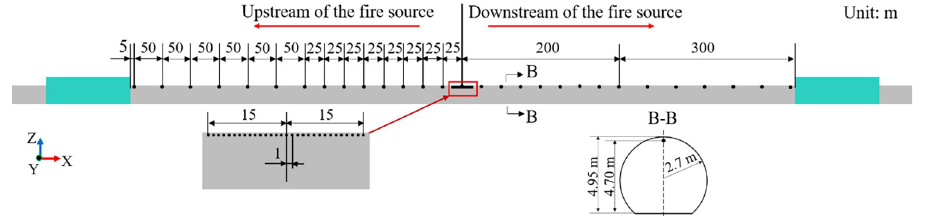
Fig 5. Schematic of the measurement points arrangement.